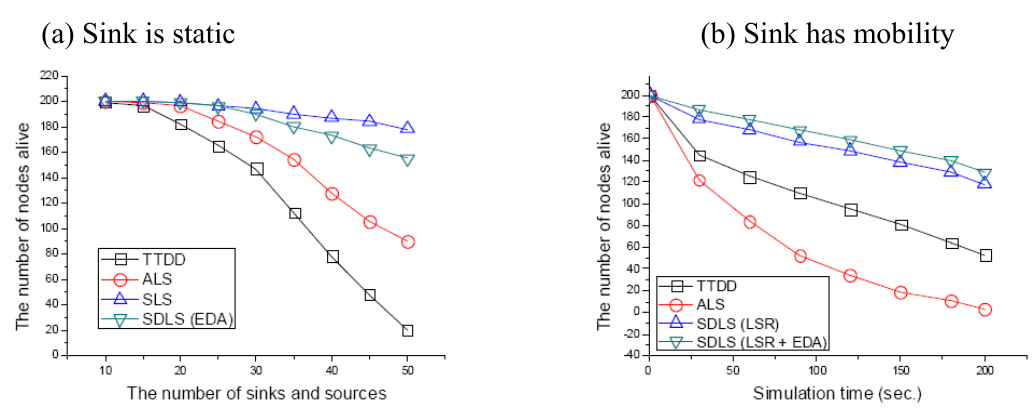
Figure 10. Network lifetime.